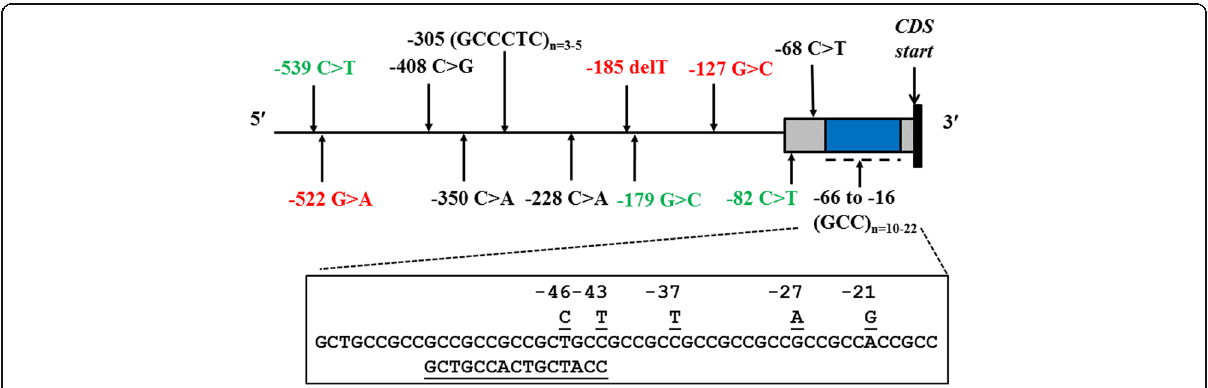
Fig. 1 Gene map displaying the position of GSTP1 promoter polymorphisms in the domestic dog and other canids. Exon 1 is shown as a shaded box, with its 3 ′ end representing the start of the coding sequence, which consists of a single adenine base. Variants found only in dogs are shown in red, while those exclusive to wolves and/or coyotes are in green. Inset shows the DNA sequence for the major microsatellite 17-repeat unit allele and the genetic polymorphisms found within this repeat region; the sequence of the compound repeat associated with certain alleles is shown below this